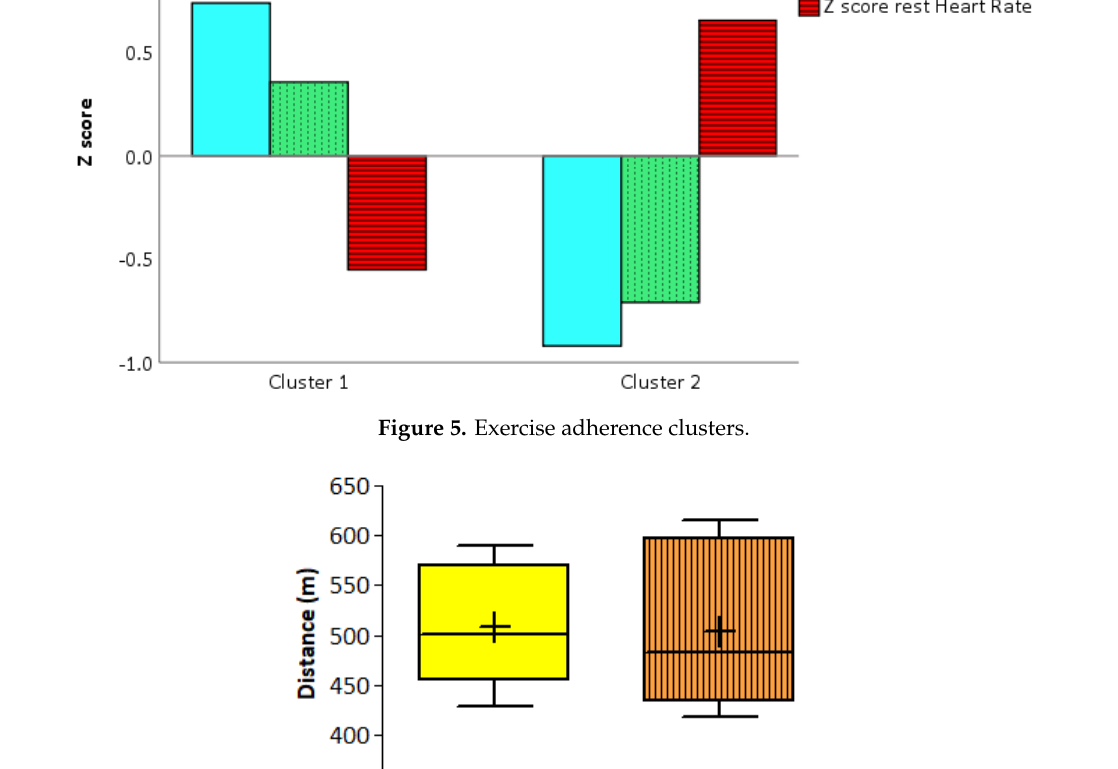
Figure 4. Walking minutes clusters.